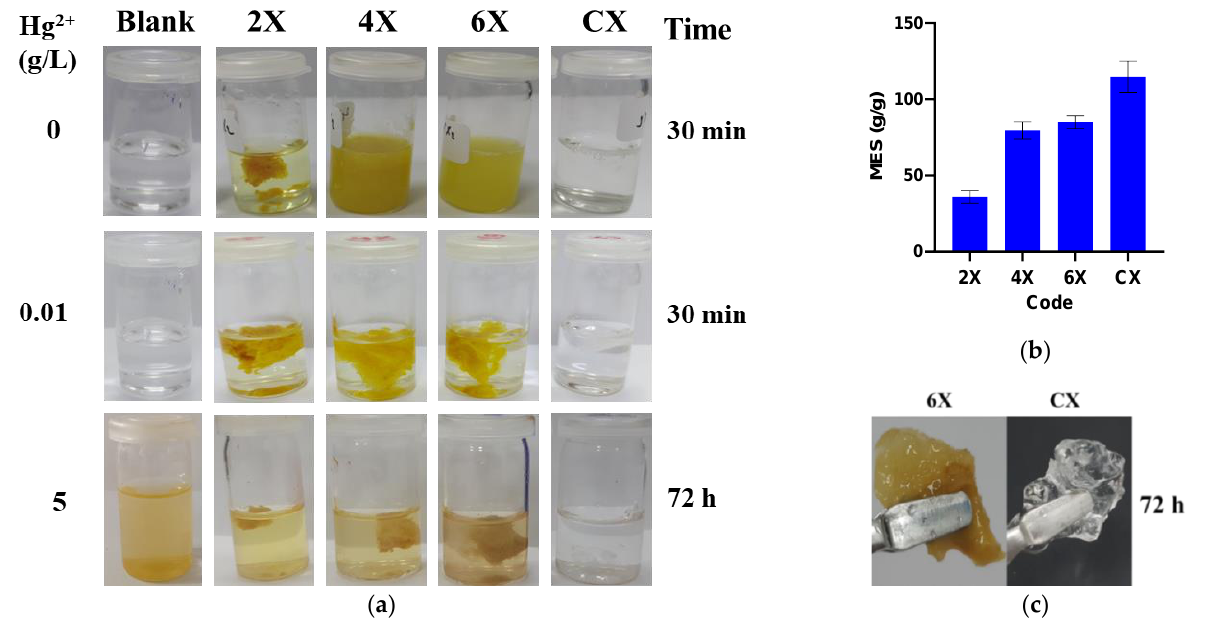
Figure 7. The xerogels’ behaviour in aqueous solutions : ( a ) images of xerogels immersed in acetic acid solution (pH = 3.7), after 30 min; in mercury acetate solution (10 mg/L, pH = 6), after 30 min; and in mercury acetate solution (5 g/L, pH = 3.7), after 72 h. ( b ) The swelling degree of the samples in the solution of mercury ions. ( c ) Aspect of the xerogels after embedding mercury ions.